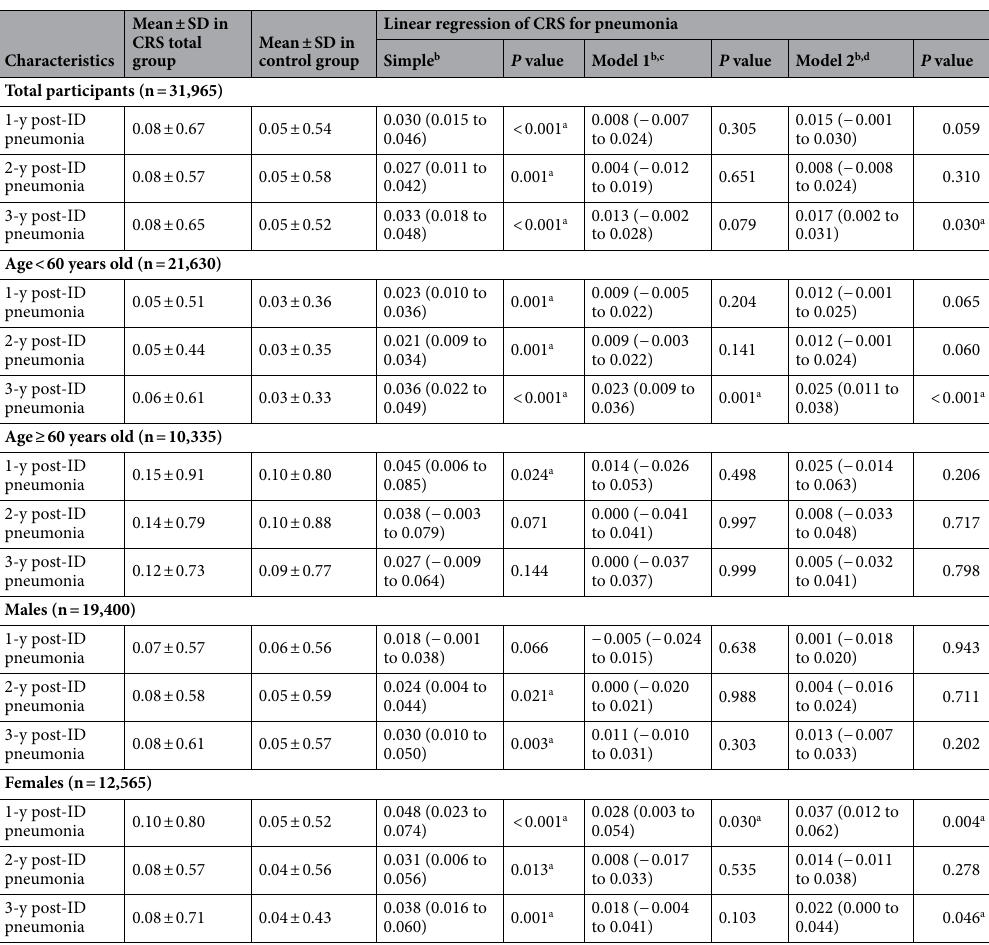
Table 2. Simple and multiple linear regression model (estimated value [95% confidence intervals]) for post index date of pneumonia (post-ID pneumonia) periods in total chronic rhinosinusitis compared to control group and subgroup analysis according to age and sex. Abbreviations: CCI, Charlson comorbidity index; COPD, chronic obstructive pulmonary disease; DBP, diastolic blood pressure; CRS, chronic rhinosinusitis; 1-y pre-ID pneumonia, pneumonia history from the date of CRS treatment (index date) to the date before 1-year periods; Post-ID pneumonia, the number of pneumonia diagnosis from the index date to the date after certain periods; SBP, systolic blood pressure; SD, standard deviation. a Linear regression model, Significance at P < 0.05. b Models were stratified by age, sex, income, and region of residence. c A model 1 was adjusted for obesity, smoking, alcohol consumption, total cholesterol, SBP, DBP, fasting blood glucose, CCI scores, asthma, and COPD. d A model 2 was adjusted for the model 1 plus 1-y pre-ID